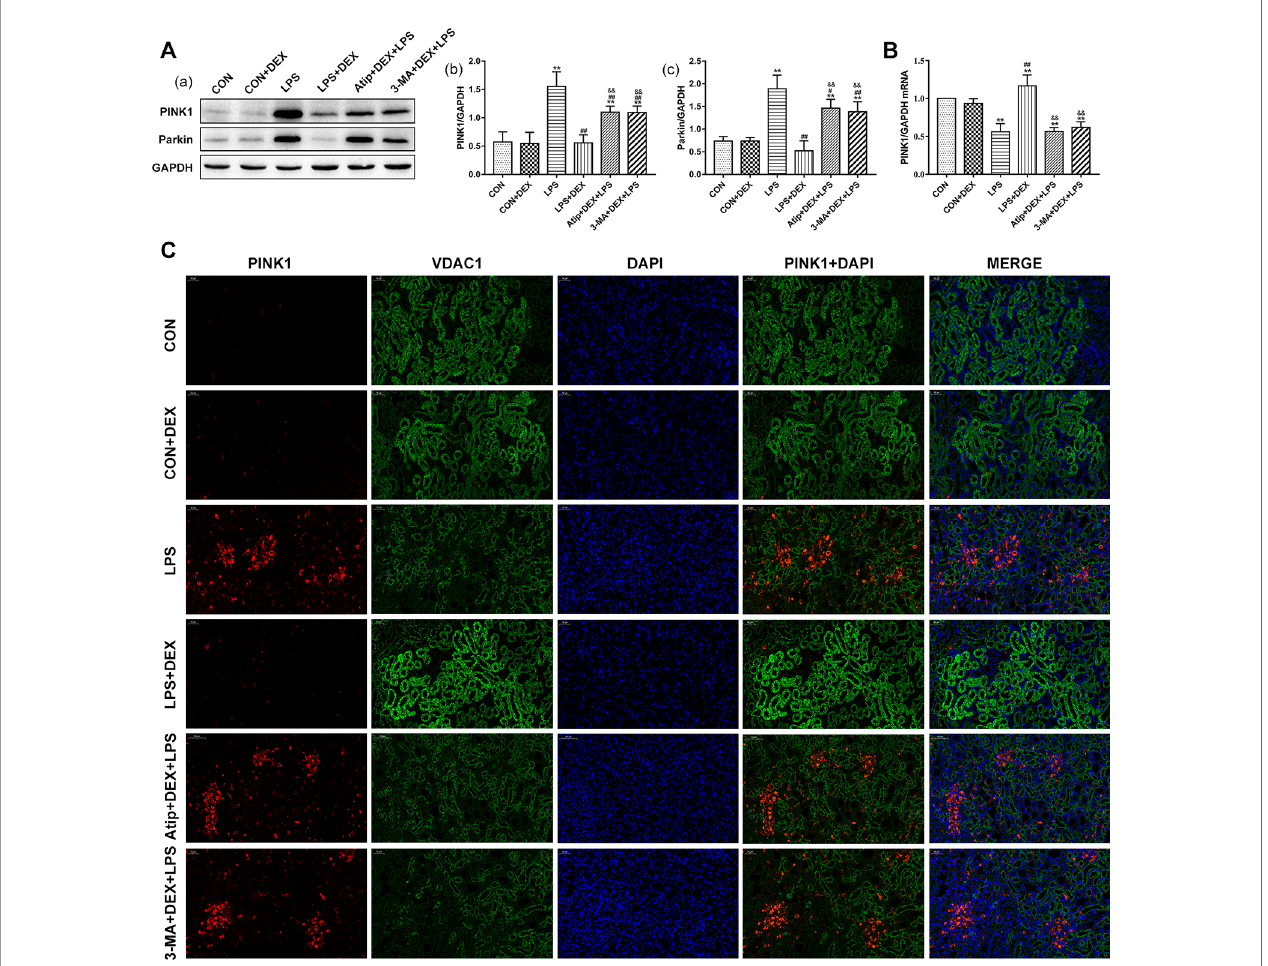
FIGURE 7 | Effects of DEX treatment on mitophagy. (A) Representative blots (a) and densitometry of PINK1 (b) and Parkin (c) signals. (B) The expression of PINK1 mRNA in renal tissue. (C) Representative images of PINK1 localization in renal tissues. Bar: 50 m m. Positive PINK1 cells were stained red, positive VDAC1 cells were stained green, with the sections counterstained with DAPI to visualize nuclei. Data are expressed as mean ± SEM (n = 6). **p < 0.01 versus CON group. #p < 0.05, ##p < 0.01 versus LPS group. &&p < 0.01 versus DEX + LPS group.